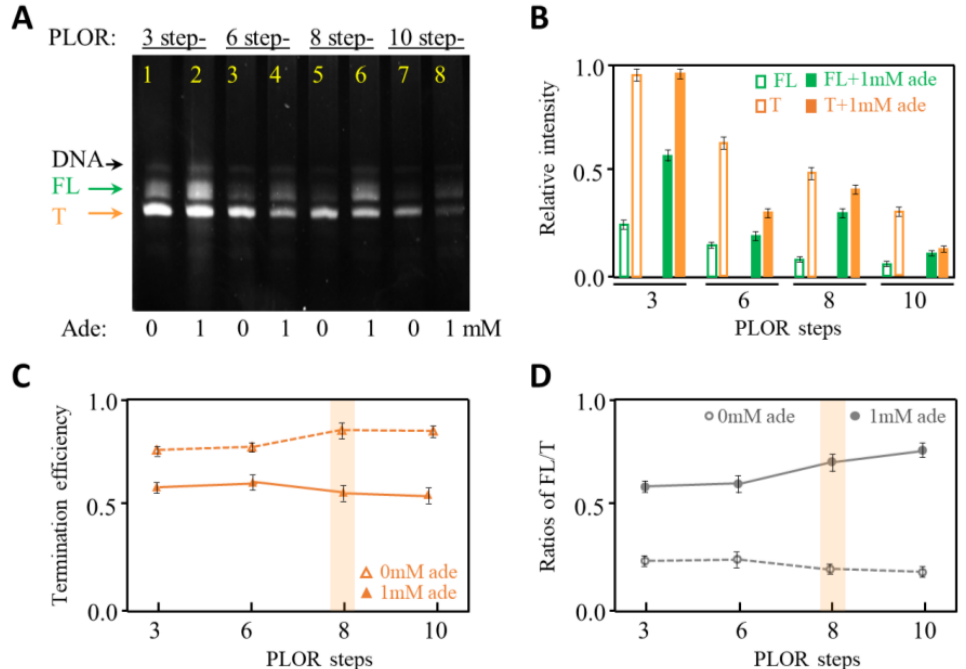
Figure 2. Transcription termination studies of adenine riboswitch without and with adenine in different PLOR reactions. ( A ) 12% denaturing PAGE gel image of the crude products generated from 3-step, 6-step, 8-step and 10-step PLOR reactions. Either 0 or 1 mM adenine was added in these single-round transcription reactions. The full-length and terminated RNA products are marked by FL and T, respectively. DNA dissociated from the solid-phase beads was observed in the gel. The gel was irradiated under UV 260 nm. ( B ) The relative intensities of FL (in green) and T (in orange) in the absence (in open columns) and presence of 1 mM adenine (in solid columns). The experiments were repeated three times. ( C ) The termination efficiency of adenine riboswitch in different PLOR reactions in the absence (in open triangles) and presence of 1 mM adenine (in solid triangles). ( D ) The ratios of FL to T of transcribing adenine riboswitch by different PLOR reactions in the absence (in open dots) and presence of 1 mM adenine (in solid dots).